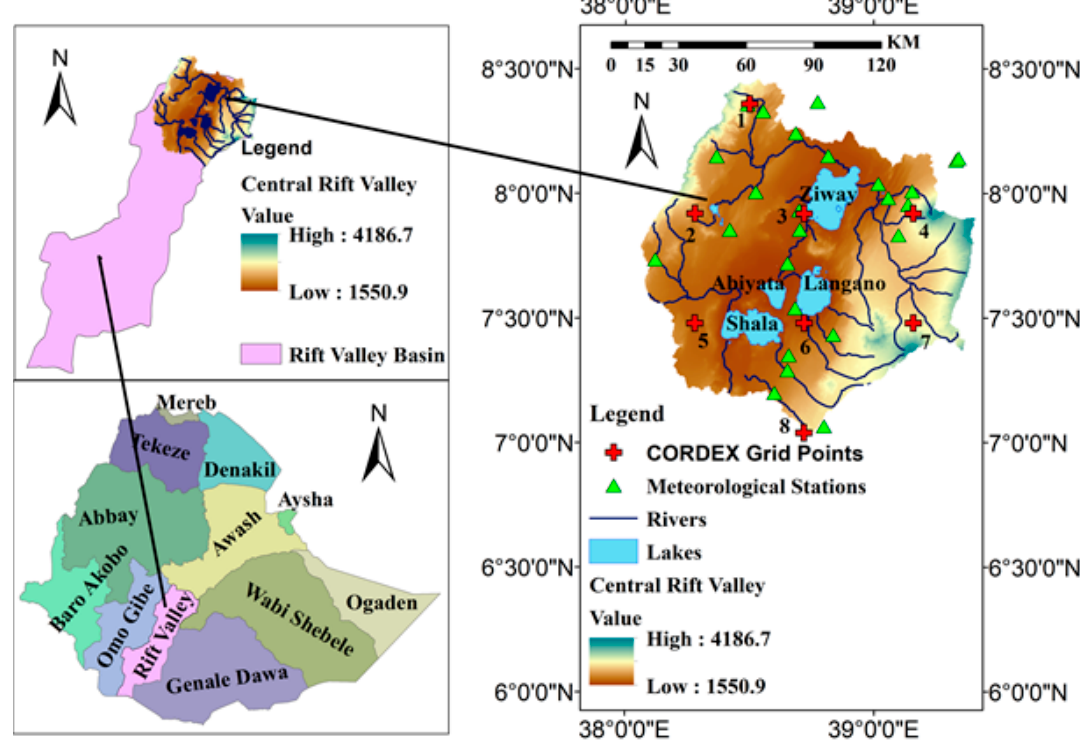
Figure 1. Location map of the study area with lakes, river networks, and grid points.